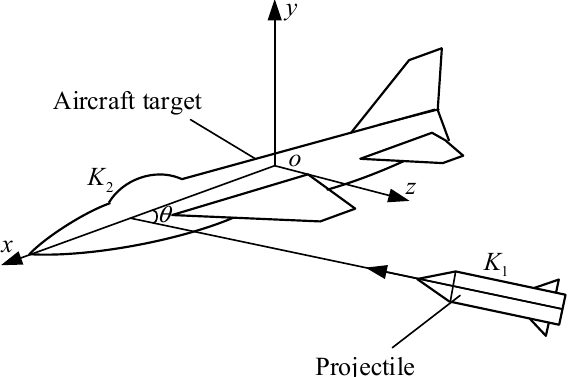
Figure 1. The intersection state of the projectile and the aircraft